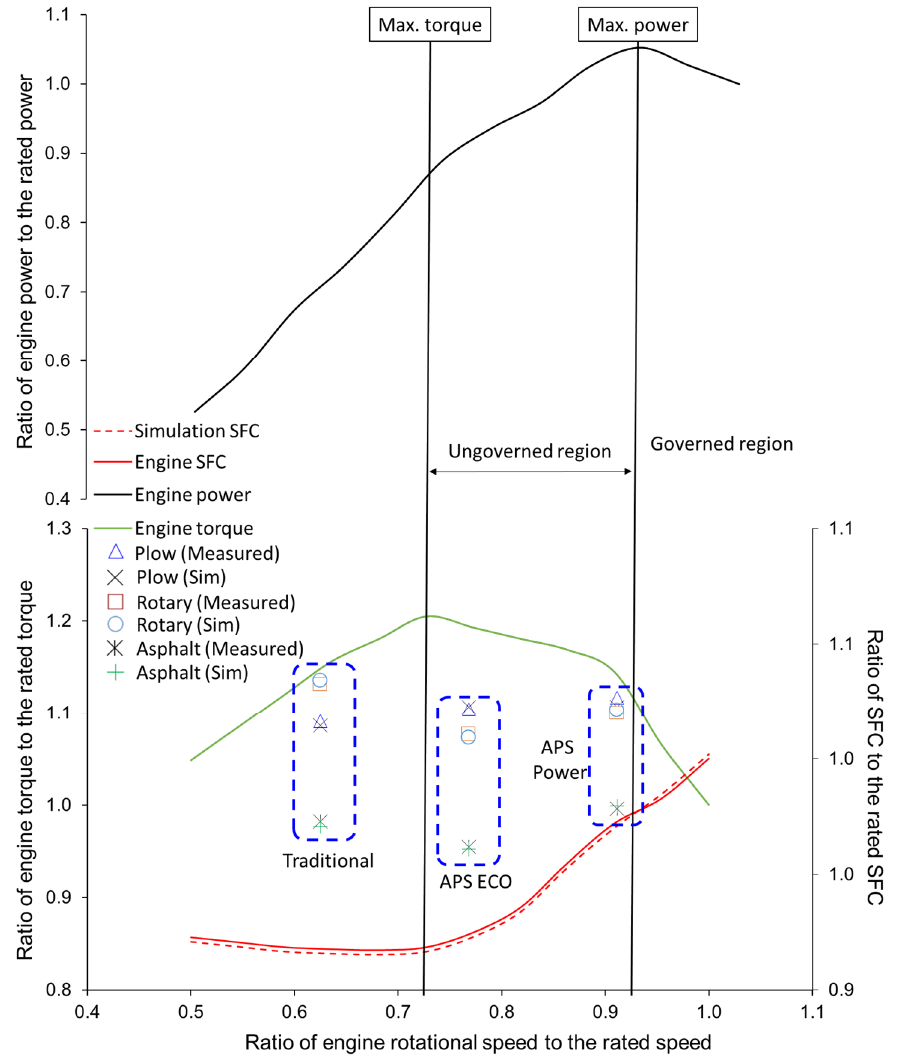
Figure 11. Performance evaluation of a partial PST tractor during asphalt, plow, and rotary